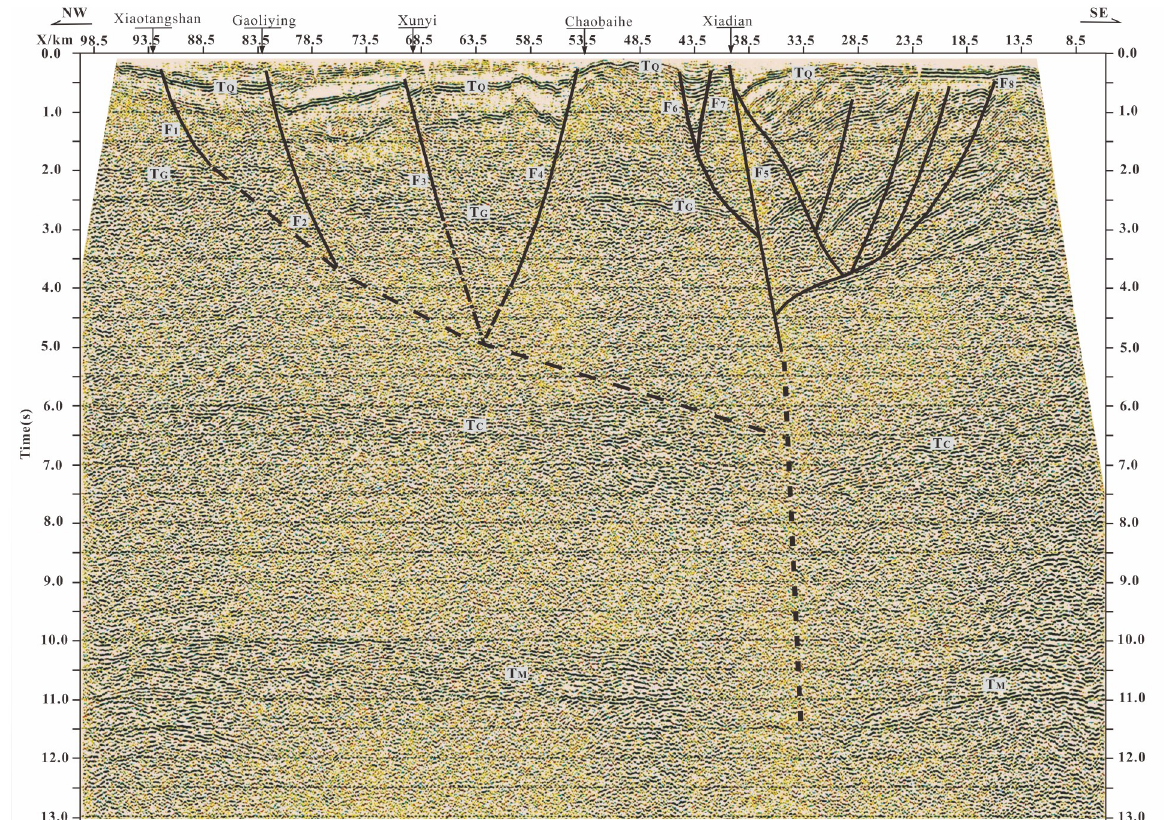
Fig 2. Deep fault structure in Beijing plain revealed by deep seismic reflection profile. The deep seismic reflection profile is adapted from Liu et al. [11], see Fig 1 for the Profile position. F1 Xiaotangshan Fault; F2 Huangzhuang-Gaoliying fault; F3 Shunyi-Liangxiang Fault; F4 Nanyuan- Tongxian Fault; F5 Xiadian Fault; F6 Daxing Fault; F7 Xiadian West Eault; F8 Xianghe fault; TQ bottom of Quaternary system; TG bottom boundary of sedimentary; TC Conrad discontinuity; TM: Moho discontinuity.